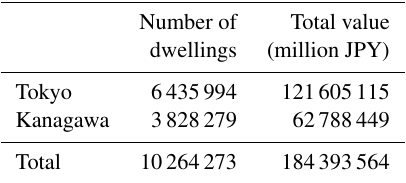
Figure 6. OEP curve for Mt Fuji losses (blue) and trigger payments